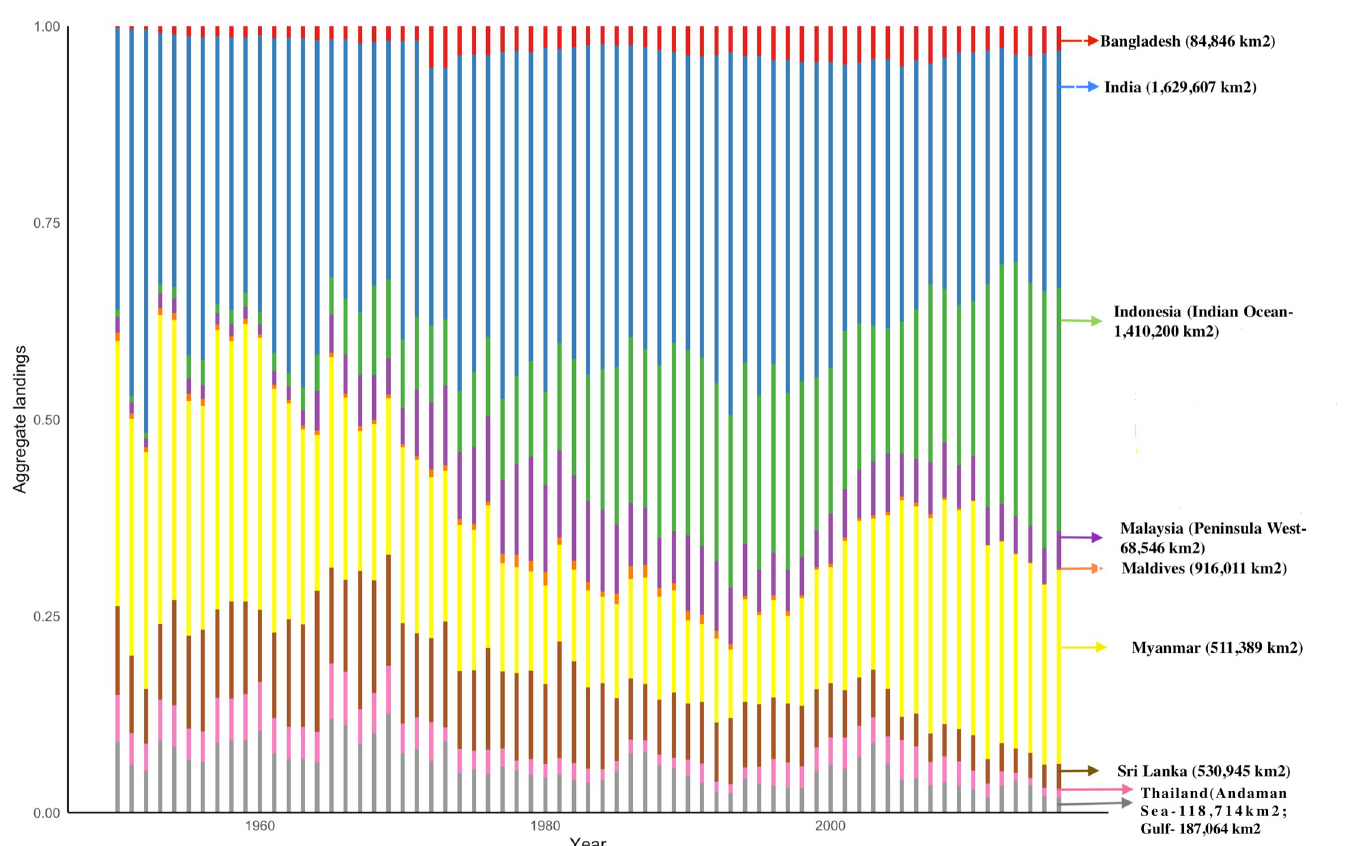
Fig 10. Relative aggregate landings of elasmobranchs in the Bay of Bengal countries from 1950–2016. Data from Sea Around Us: http://www.seaaroundus.org. The area of the EEZ is added for each country at the right side of the graph to illustrate the relative area in which fishing activities are operated.